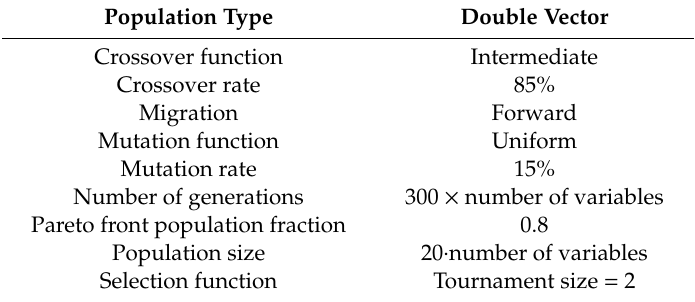
Table 4. The Nondominated Sorting Genetic Algorithm (NSGA II)